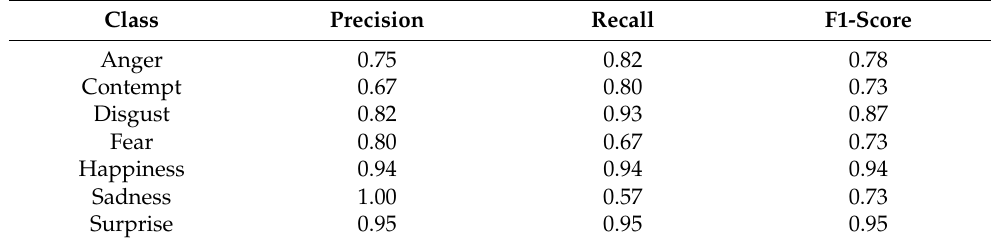
Table 13. SVM training results for iteration 3 of K-fold stratified using dataset2 .